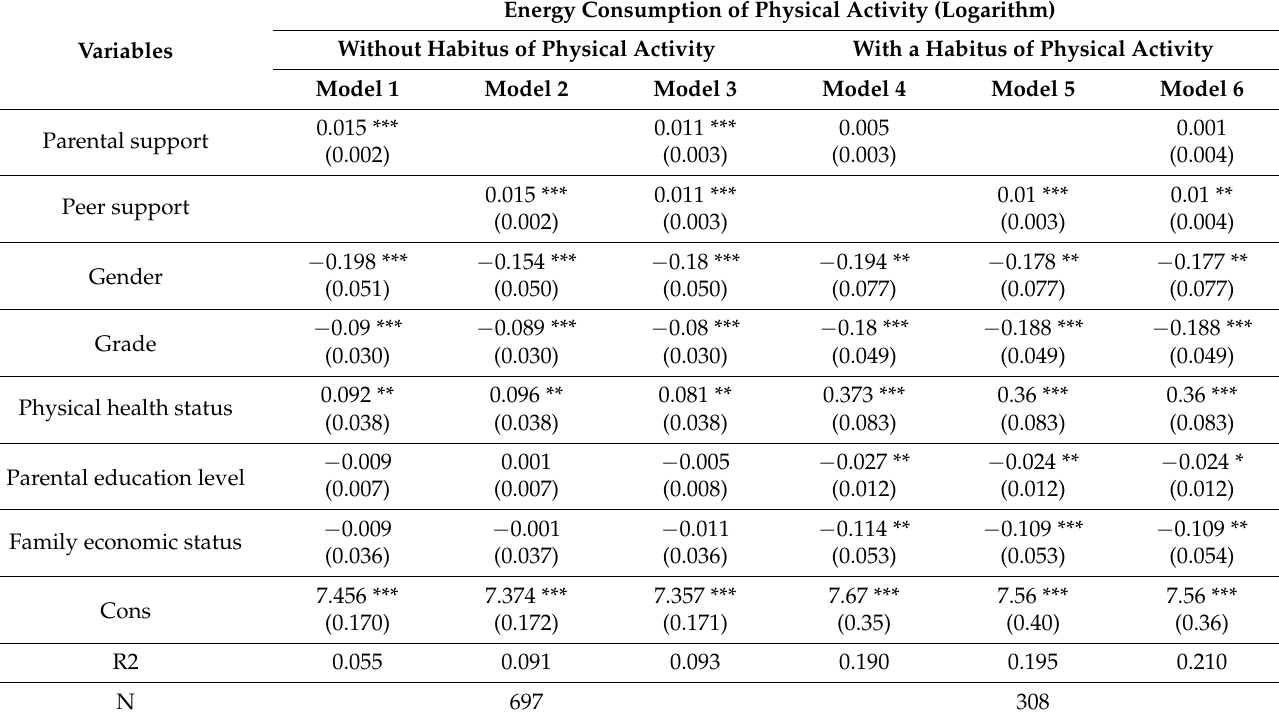
Table 7. Fractional regression